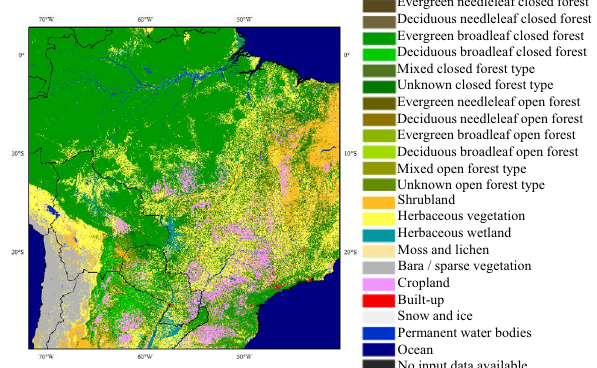
Figure 12. Land cover map of hotspot-3 (Brazil). This figure was generated using ArcGIS version 10.1 (https:// www. esri. com/ en- us/ home). Shape for countries of the world downloaded from Geografía, SIG y Cartografía Digital. (http:// tapiq uen- sig. jimdo free. com). The land cover data was from Buchhorn et al. 32 (https:// land. coper nicus. eu/ global/ produ cts/ lc).